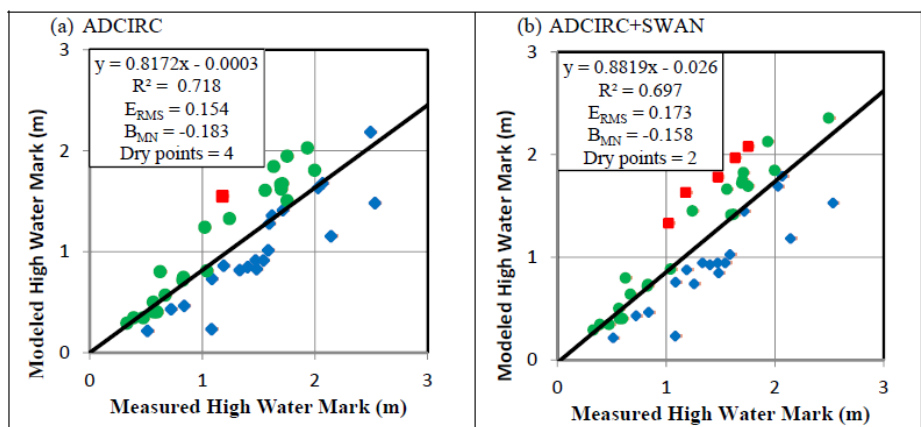
Figure 6. Comparison between the modelled and measured HWMs at the various USGS locations. ( a ) ADCIRC; ( b ) ADCIRC+SWAN. Red points indicate overprediction by the model; blue points indicate underprediction; green points indicate a match within 0.5 m. The black line represents the best line of